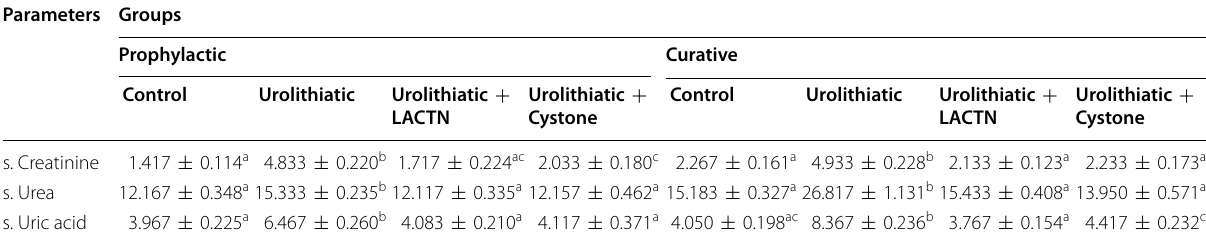
Values are expressed as mean SEM ( n 6). ANOVA post hoc with Duncan’s test was performed to compare between groups. Values with different row superscript ± = letters of the same regimen are significantly different ( P < 0.05)